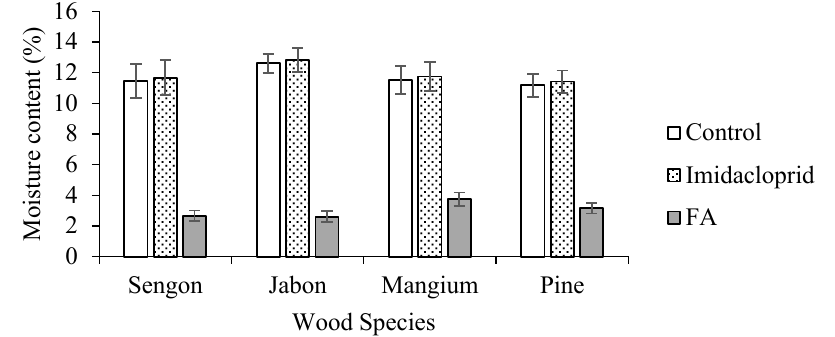
Figure 5. Moisture content of each wood species according to treatment.